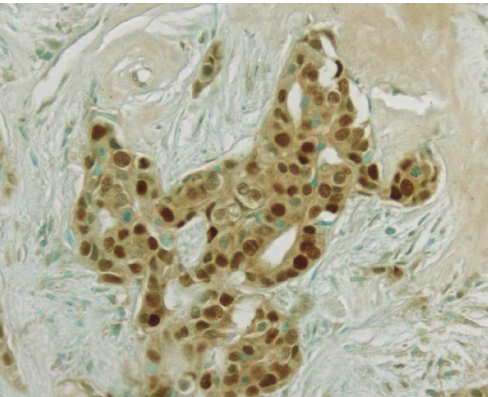
Figure 5: Showing strong p53 staining of nuclei in CPA. Original magnification x40.